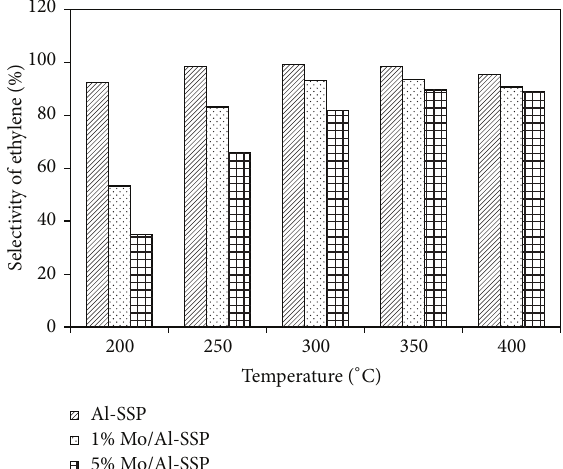
Figure 8: Ethylene selectivity at different temperatures of all catalysts.